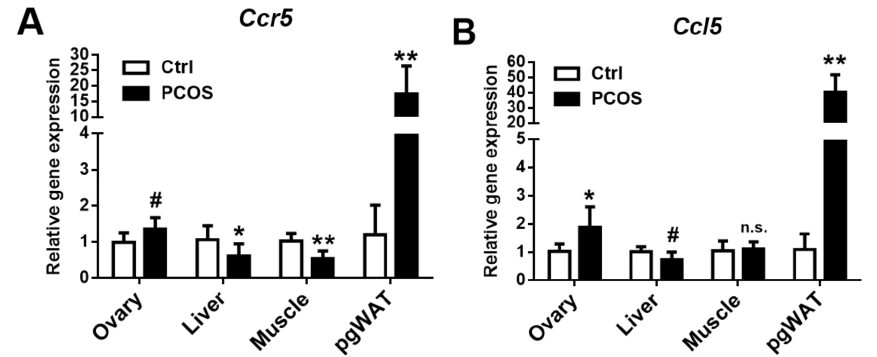
Figure 9. CCR5 ( A ) and CCL5 ( B ) expression in the ovary, liver, muscle, and perigonadal white adipose tissue (pgWAT) in the letrozole-treated and the control mice. The results are expressed as the mean ± SD. n.s.: not significant; # p < 0.1; * p < 0.05; ** p < 0.01, compared with the control mice.